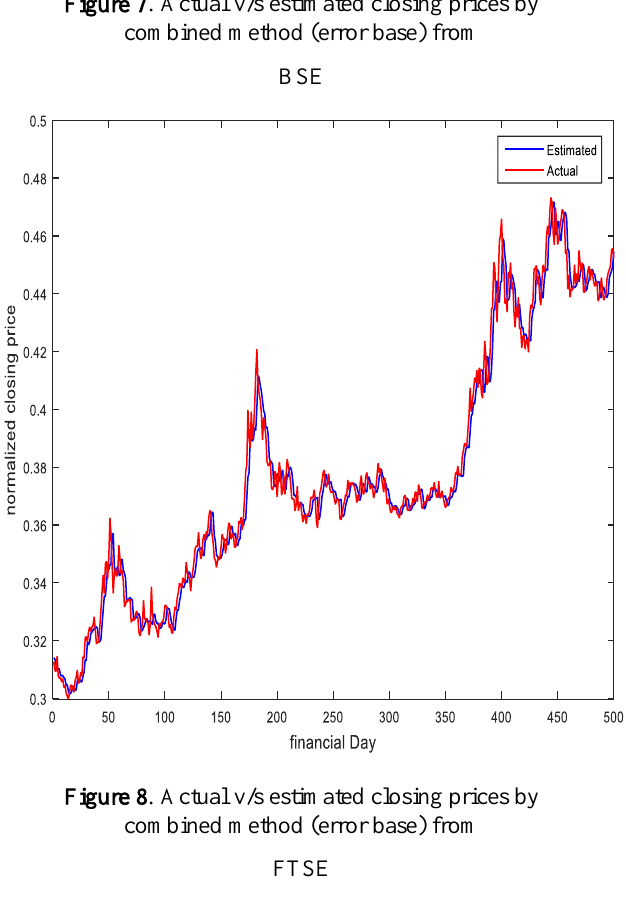
Figure 7 . Actual v/s estimated closing prices by combined method (error base) from BSE